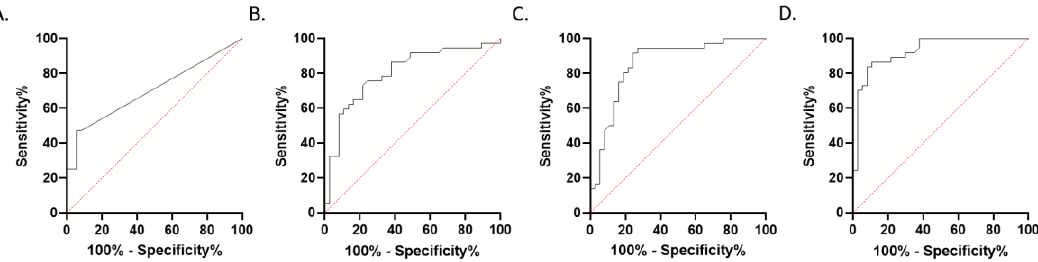
Figure 4. ROC analysis of CBV measurements and the multiparametric model for differentiation of GBM and PCNSL. ROC analysis of DSC CBV imaging for differentiation of patients with GBM and PCNSL by minimum ( A ), mean ( B ) and maximum CBV ( C ) and ratio CBV ( D ).